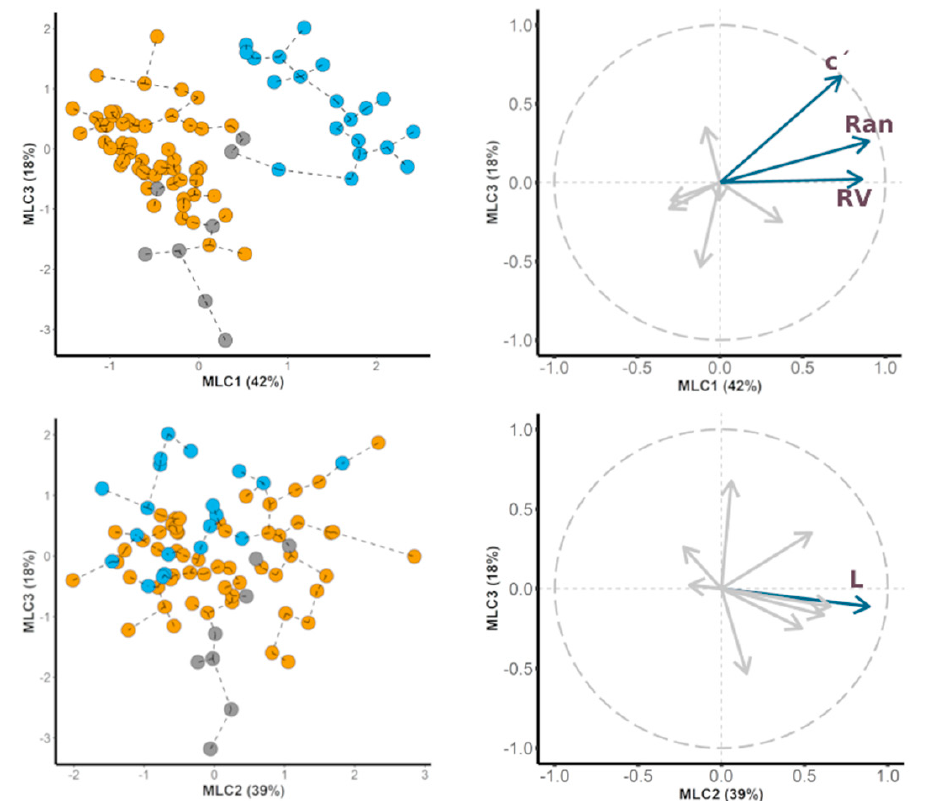
Figure 2. Principal component on morphometric characters to characterize Criconema annuliferum - complex species with a superimposed minimum spanning tree (based on Euclidean distance). Blue arrows indicate morphometric variables with projected eigenvalue > 0.70.